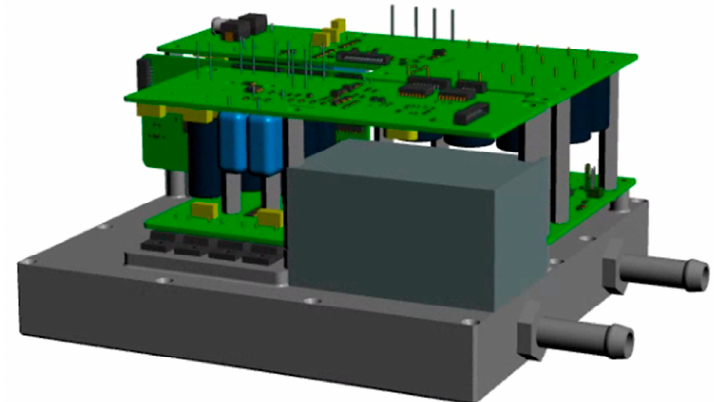
Figure 7. Three-dimensional (3D) assembly drawing of the 3.3 kW onboard charger (OBC) prototype with a heat spreader. The system has two power boards. Lossy parts are on the bottom board and bulky parts are on the top board.